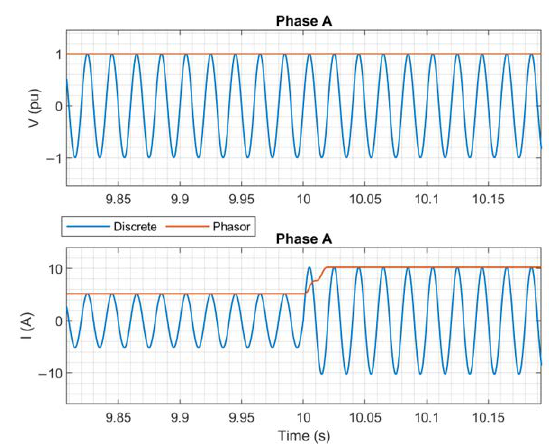
Figure 6. Step increase in power demand at 10 s. ( upper ) Voltage synchronization between the two interconnected domains. ( lower ) Prompt change in current drawn analyzed in both domains due to step increase in power